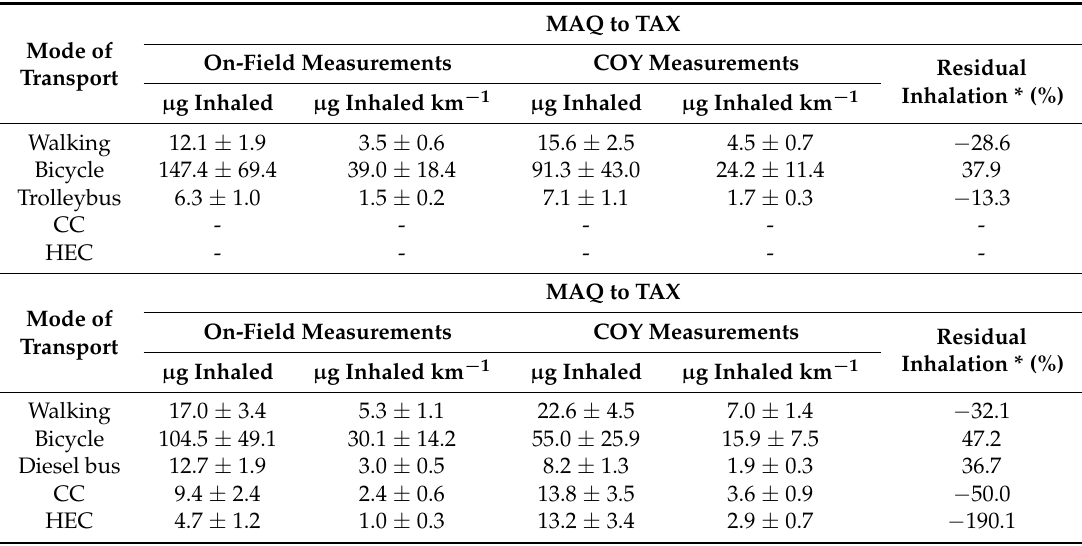
Table 4. Distance, inhaled PM 2.5 and residual inhalation by route and mode of transport along MAQ